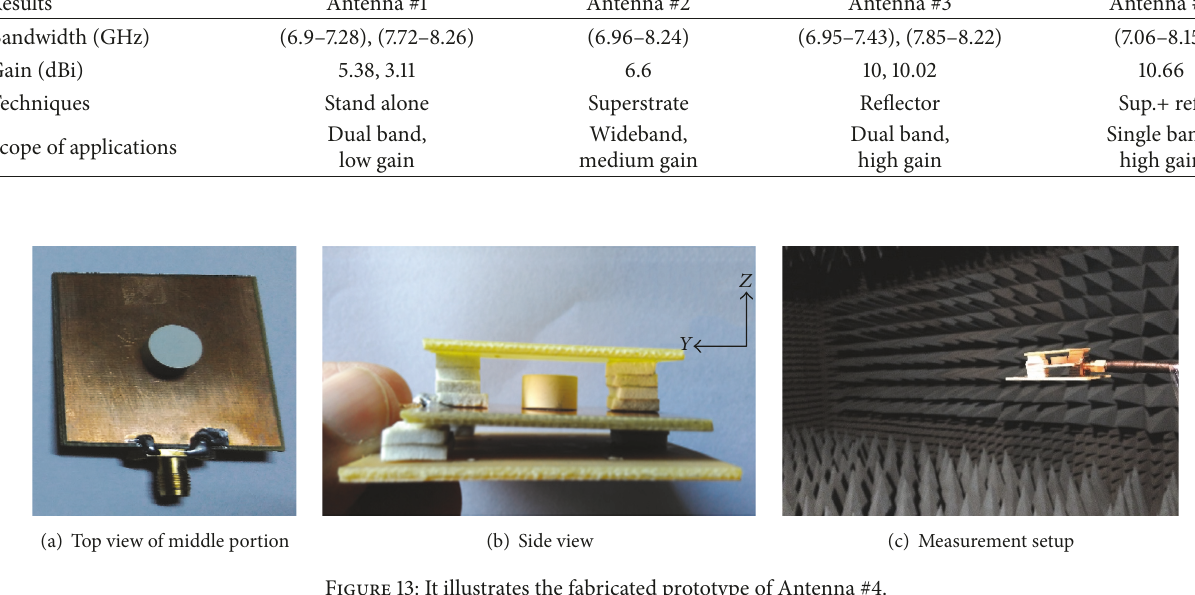
Figure 13: It illustrates the fabricated prototype of Antenna #4.